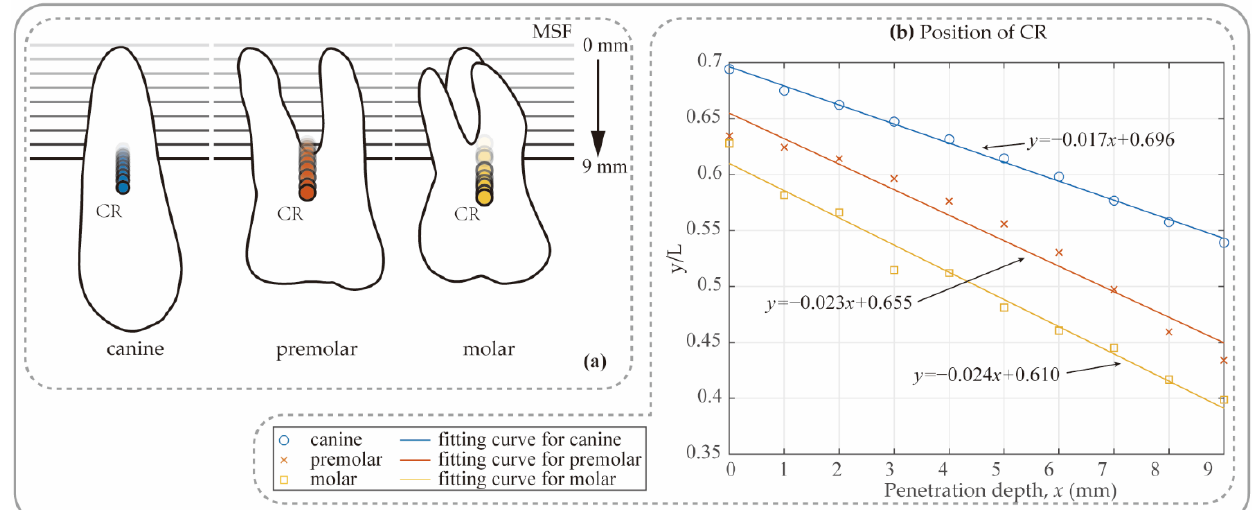
Figure 4. Changes of CR positions of three teeth against the penetration depths. ( a ) Schematic of the CR positions for different depths of root penetration. The blue horizontal lines present the different heights of MSFs. Colored circles with black strokes indicate the changes of CR positions because of the MSF sinking. Different transparency of the graphics represents different depths and corresponding CR positions. ( b ) The ratio of y to L against the penetration depth based on the simulation results. Experimental data and the linear model fitting.